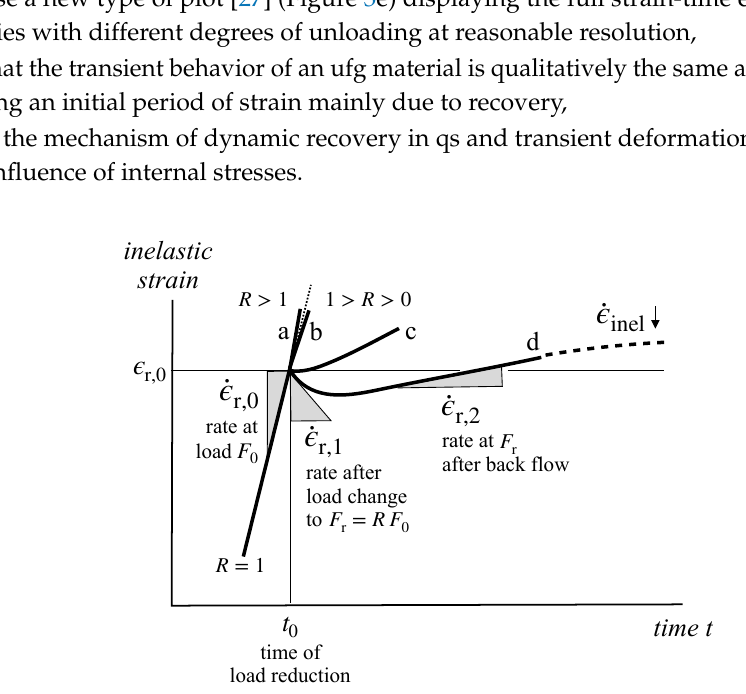
Figure 2. Response of inelastic strain to fast changes of creep load from F 0 to F r = R F 0 during deformation at time t 0 and strain (cid:101) r,0 for (a) small R -increase, (b) small R -decrease, (c) medium R -decrease causing ˙ (cid:101) r,1 = 0, (d) large R -decrease causing net back